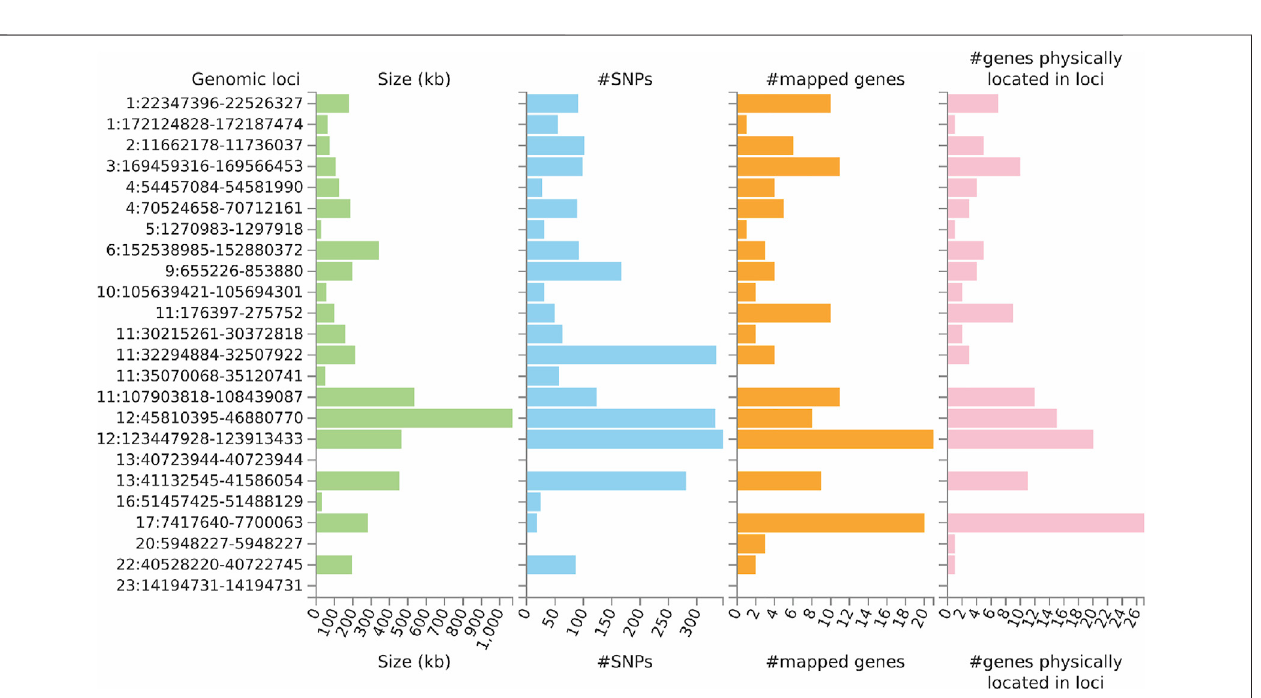
Frontiers in Genetics |